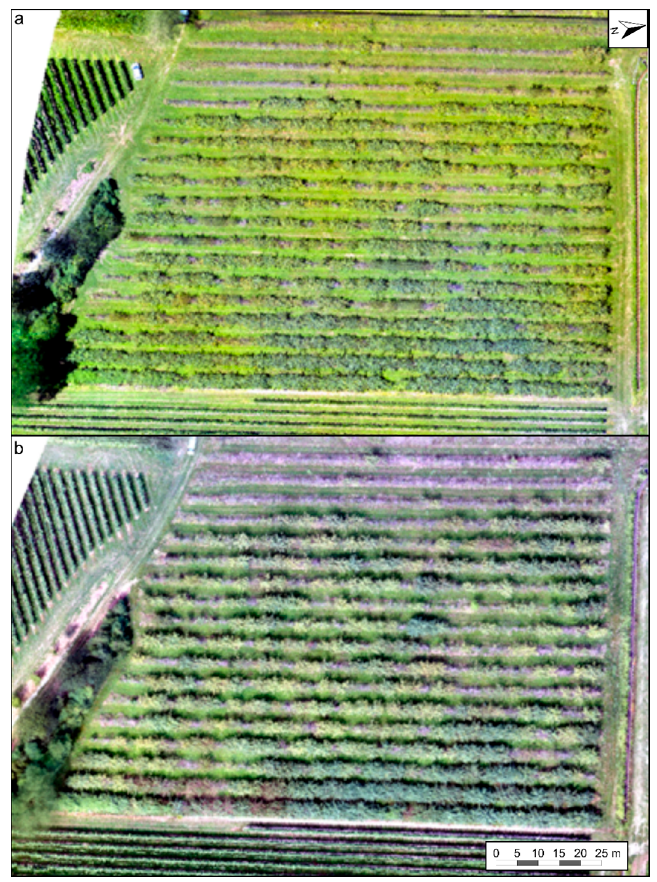
Figure A1. Low resolution RGB orthomosaics in 2017 ( a ) and 2018 ( b ).